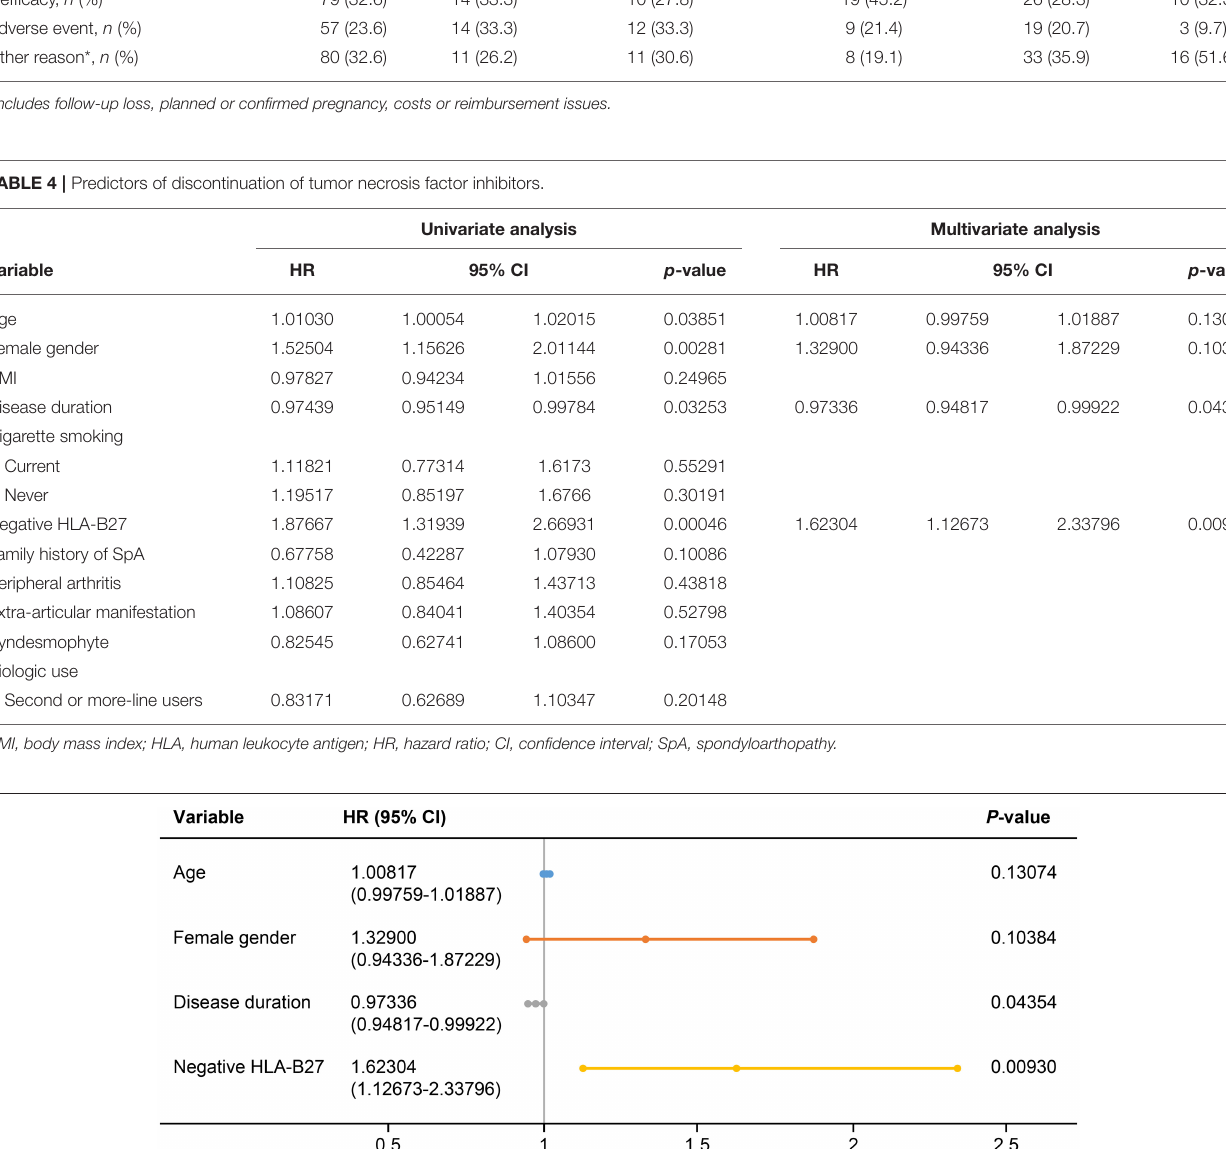
persistence rates to identify the causes of TNFi discontinuation in patients with AS and in patients with PsA. The patients were treated with adalimumab, etanercept, or infliximab with 84.7% of them maintaining their TNFis therapy during